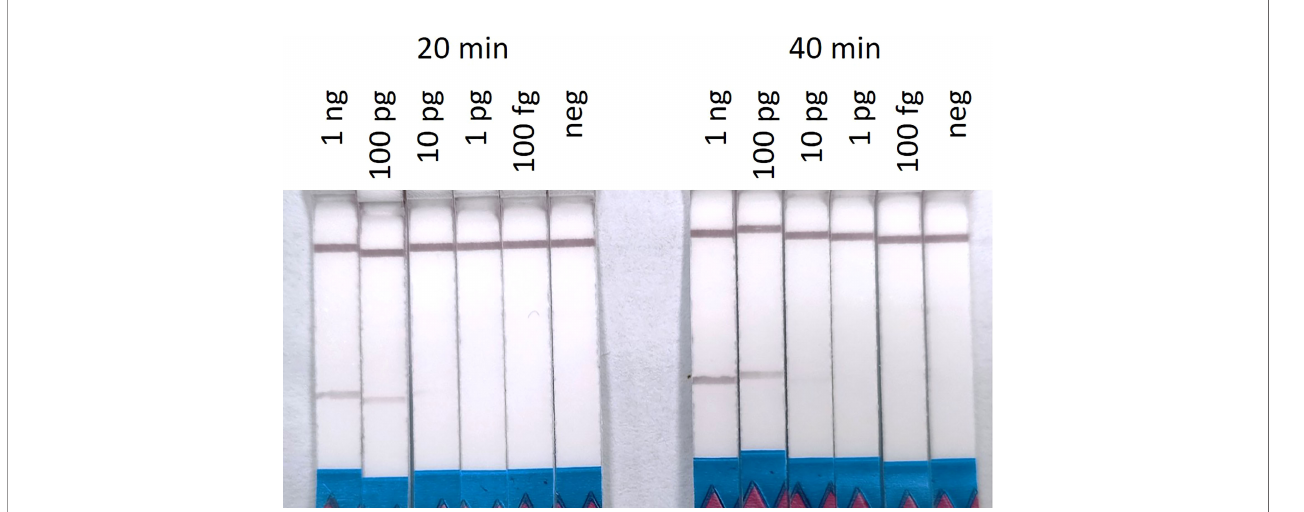
FIGURE 4 | Recombinase Polymorphism Ampli fi cation-Lateral Flow (RPA-LF) assay on 10-fold serial dilution of Sabella spallanzanii ranging from 1 ng to 100 fg after 20 min and 40 min of ampli fi cation. Positive signals could be seen down to 10 pg of